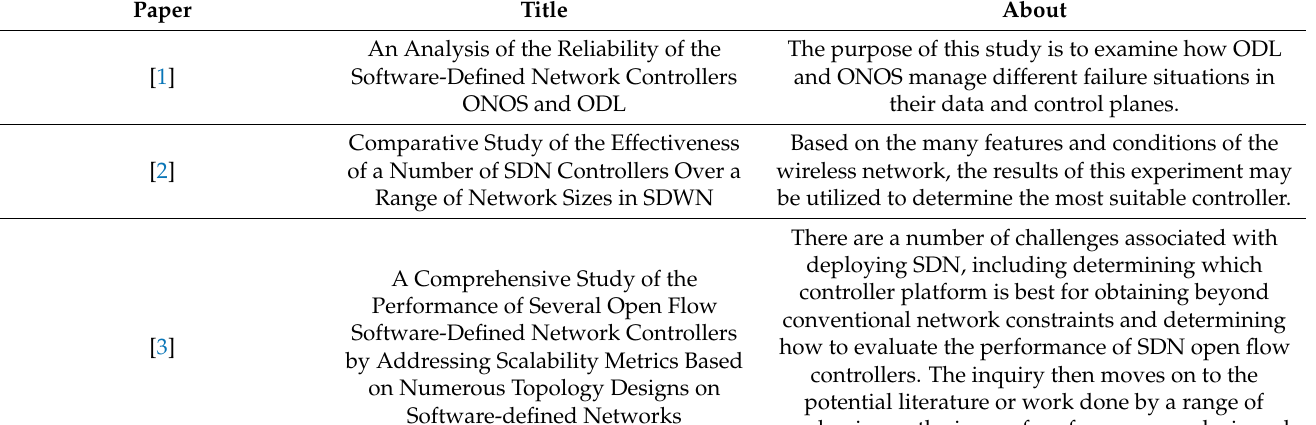
Table 1. Literature Survey